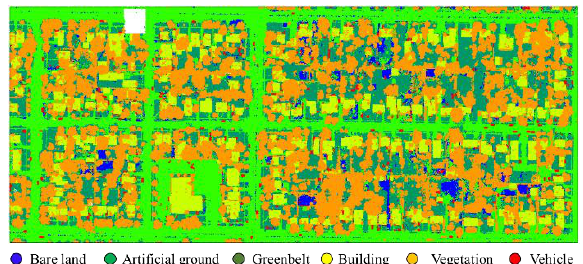
Figure 11. The classification result of ground points, the points colored by red, green, and blue are artificial ground, greenbelts, and bare land, respectively.